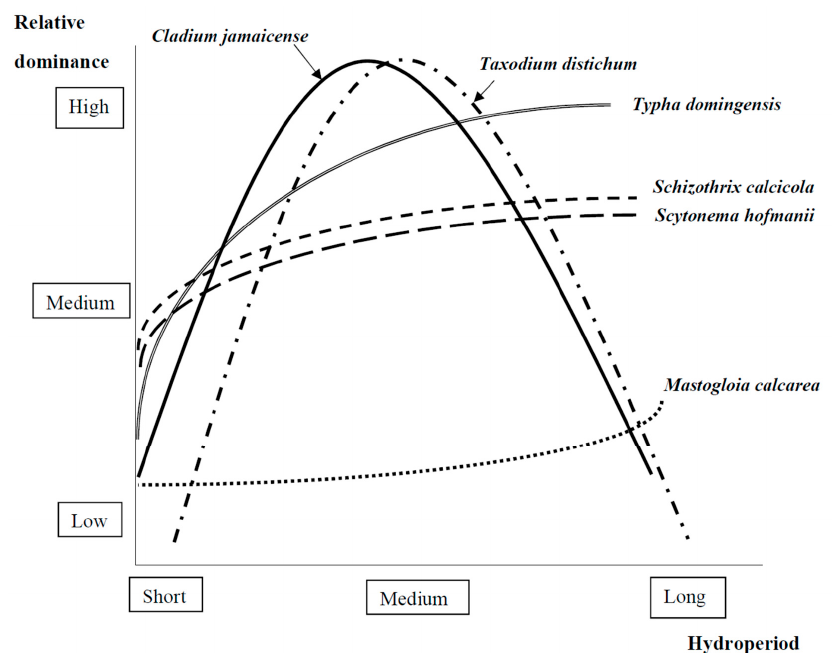
Figure 2. Examples of observed relationships between relative dominance of different foundation species and hydroperiod in the freshwater Everglades ecosystem based on the literature reviewed (see Section 2.1.1 and refer to Marazzi et al. [40] for cyanobacteria and diatom species; Ross et al. [53], Todd et al. 2010 [55], Sah et al. [56], Toth [57] and Busch et al. [58] for sawgrass; Newman et al. [25] for cattail; and Allen et al. [68], Megonigal & Day [69], Shanklin & Kozlowski [70] and Elcan J.M.; Pezeshki [77] for bald cypress). Scytonema hofmanii and Schizothrix calcicola are difficult to identify through microscopy and hence some studies refer to them as Scytonema sp. and Schizothrix sp. (e.g., Marazzi et al.